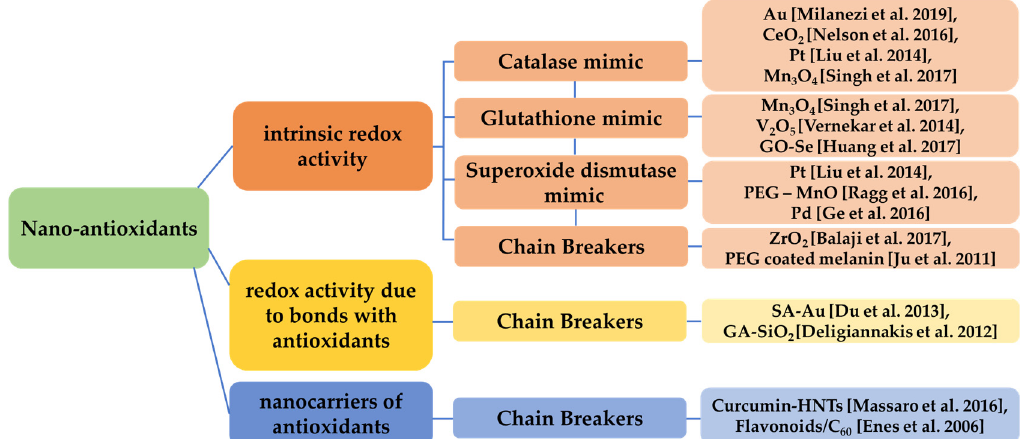
Figure 5. Categorization of nanomaterials acting as antioxidants based on their redox activity. Various nanomaterials present intrinsic redox activity (catalase-like, glutathione-like, superoxide dismutase-like, chain breaking) [87,92,94–101], redox activity related to bonds of the nanomaterial with other antioxidants [102,103] and redox activity due to the fact that act as nanocarriers of antioxidants [104,105].